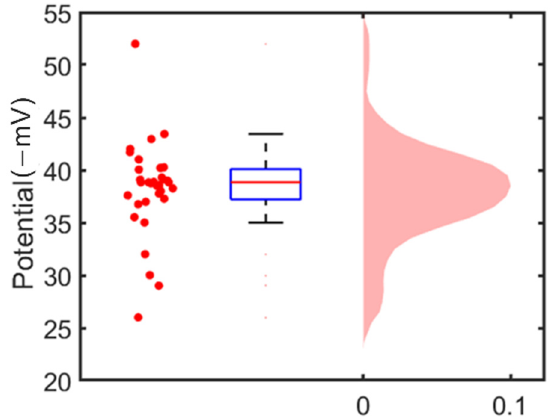
Figure 5. (Left) scattered plot of surface potentials of individual MPs; (center) boxplot of the surface potential measurement of MPs; (right) distribution of the surface potentials of the 30 MPs.